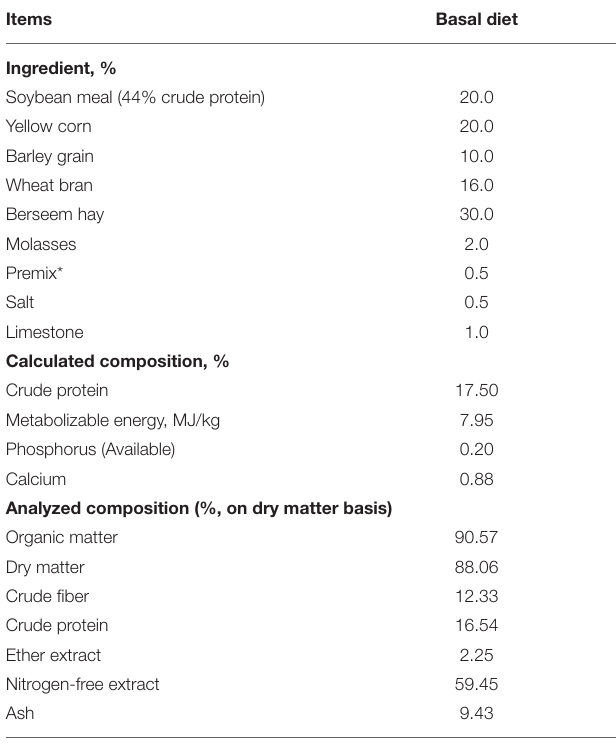
TABLE 1 | Composition of the basal diet of growing rabbits (as